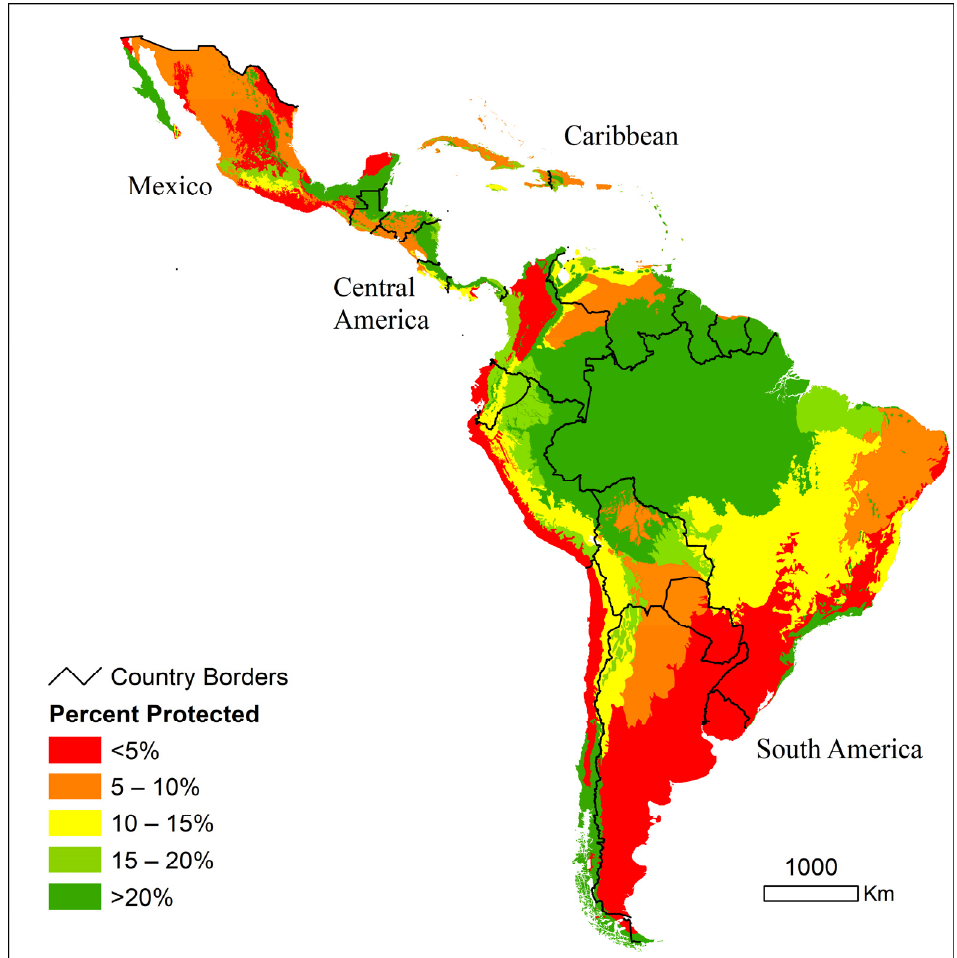
Figure 4. Percent of ecoregions that have protection (including all WDPA categories, but not in- cluding points). ing